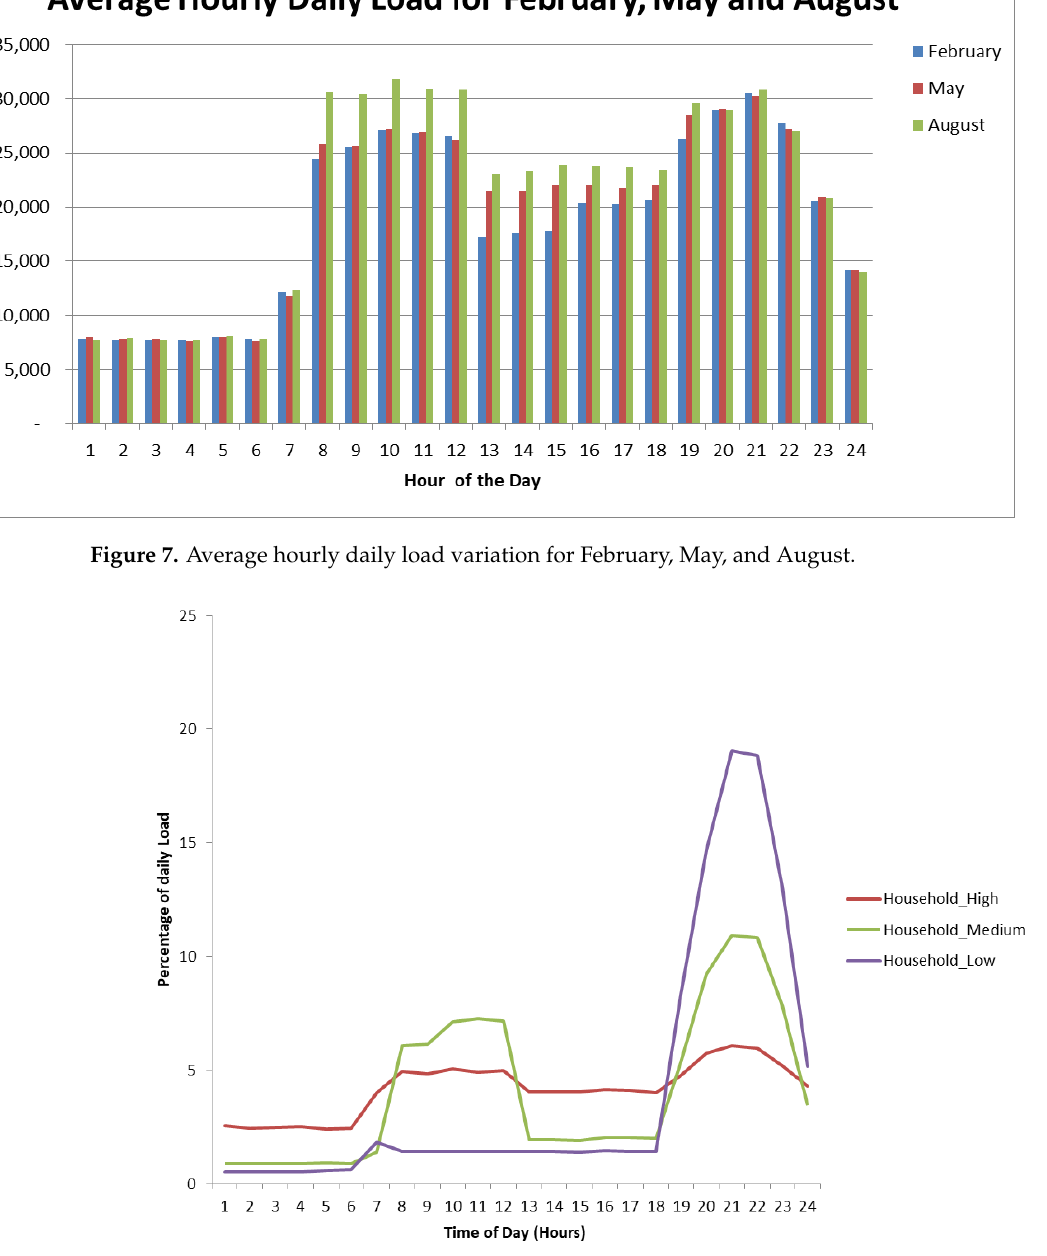
Figure 9. Load profile for the maize mill in August, May, and February.